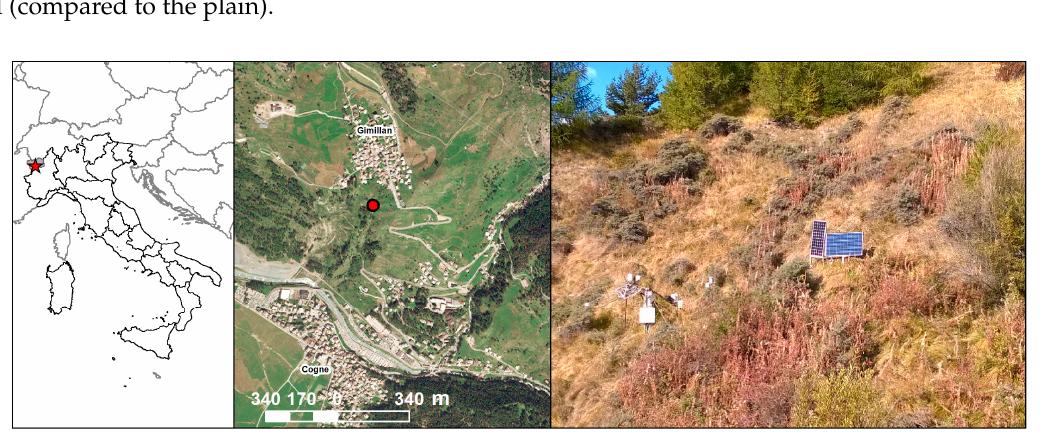
Figure 4. Experimental site located in Cogne (Aosta–Italy) and a picture shot in October